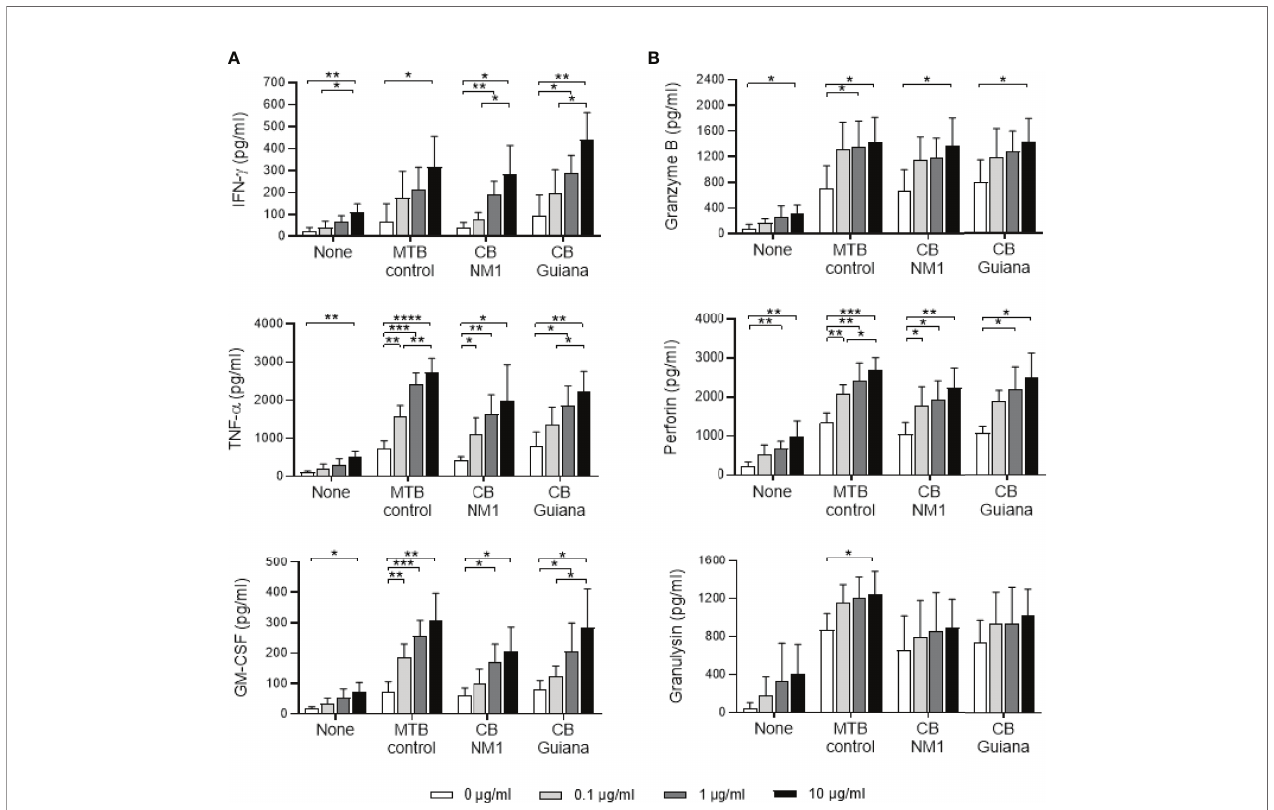
FIGURE 6 | Anti-BTN3A agonist antibody increases the secretion of cytokines and cytotoxic molecules in V g 9V d 2 T cell/infected-monocyte co-cultures. Monocytes isolated from healthy donors (n = 4) previously infected 24 hours with C. burnetii NM1 (50 MOI) or with M. tuberculosis (5 MOI) were co-cultured with autologous V g 9V d 2 T cells (E:T ratio of 1:1) in the presence of anti-BTN3A antibody (clone 20.1) (0-10 µg/ml). After 4 hours of co-culture, the culture supernatants were analyzed for the presence of cytokines ( A , left panel) and cytotoxic molecules ( B , right panel) by ELISA assay. Data were analyzed using a normality test and a parametric t test. Values represent mean ± standard deviation. * p < 0.05 , ** p < 0.01 , *** p < 0.001 and **** p < 0.0001